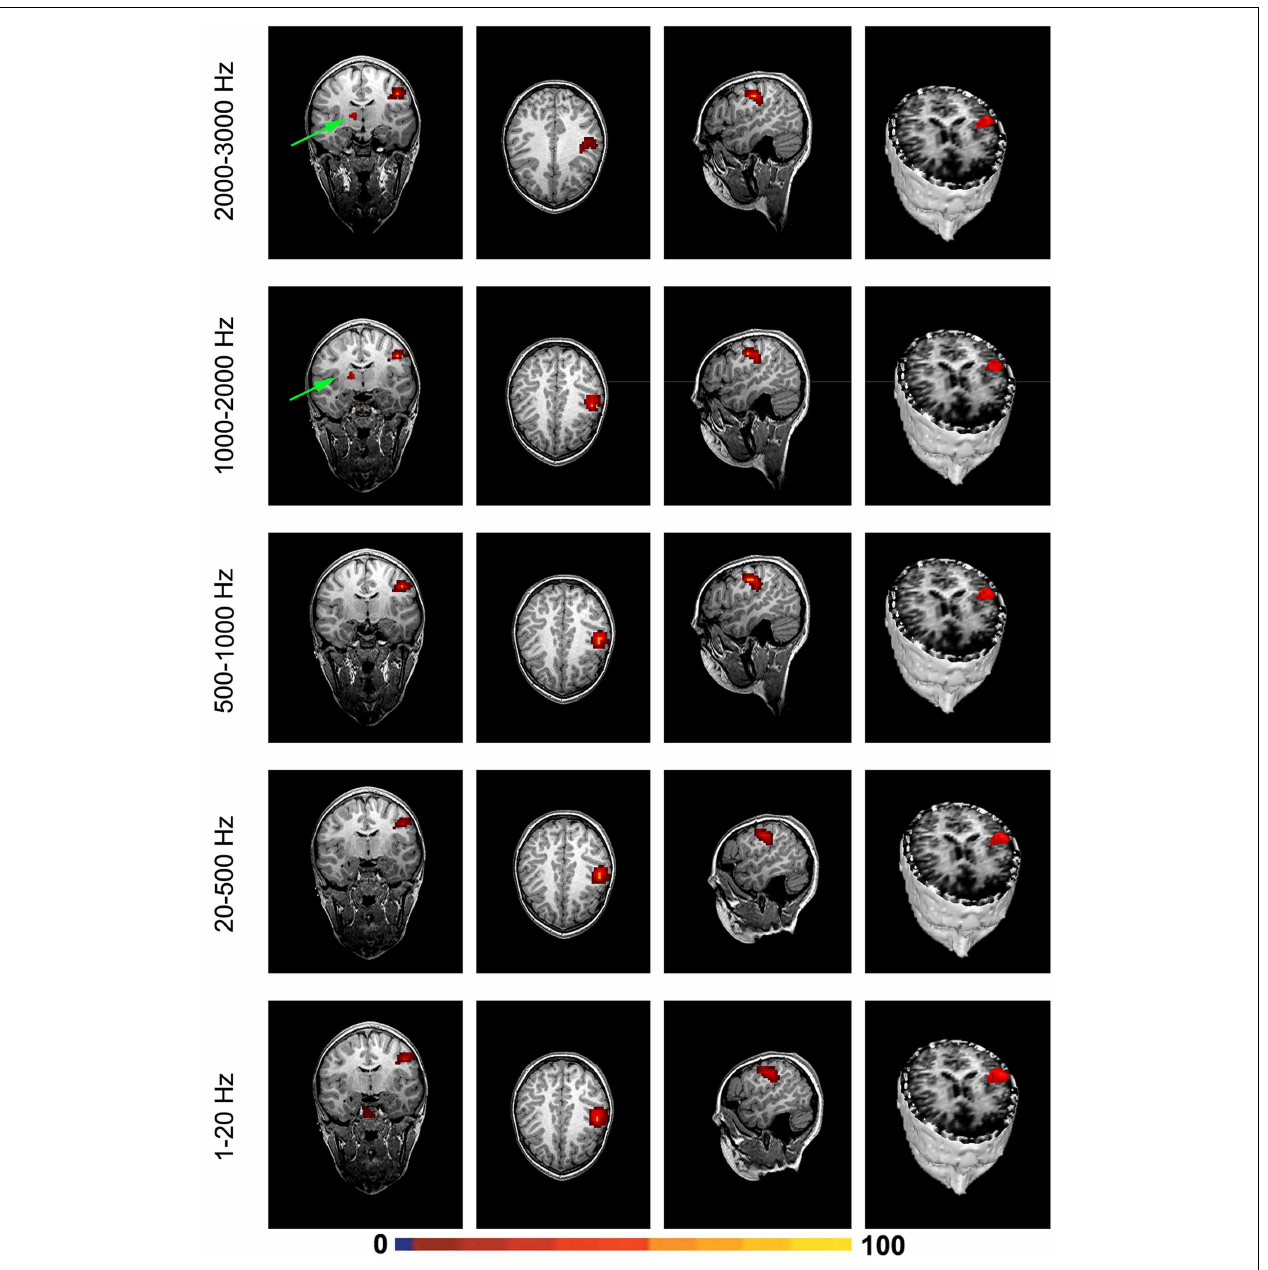
frequency range.Very high-frequency signals (1000–2000 and 2000–3000Hz) may be also generated by the deep brain area, which is possibly from the